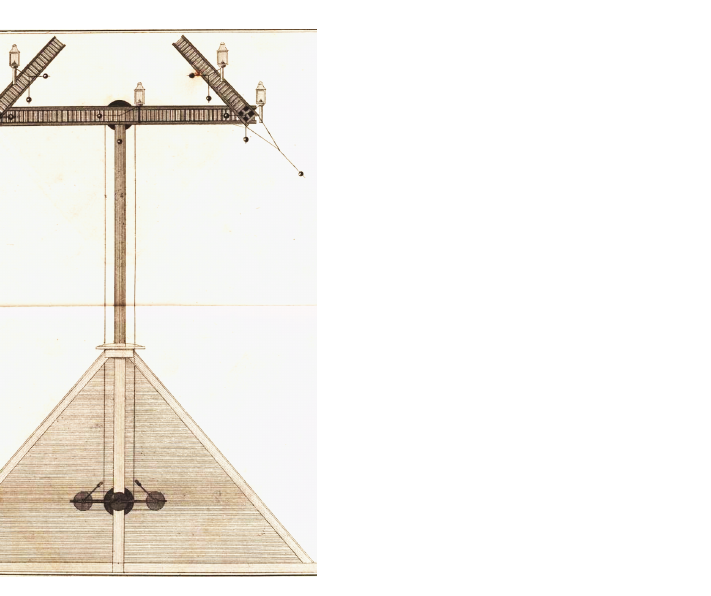
Figure 1. The Chappe telegraph adopted by the French state as depicted in Ignace Chappe’s book. Three arms were used to convey signals and each could rotate at steps of 45°. (Source: [9]). In September 1793, the General Assembly approved the establishment of a line of 15 towers from Paris to Lille. On 16 July 1794, the Paris-Lille line was completed and tested with 18 towers, covering a distance of 190 km with hops between 10 and 15